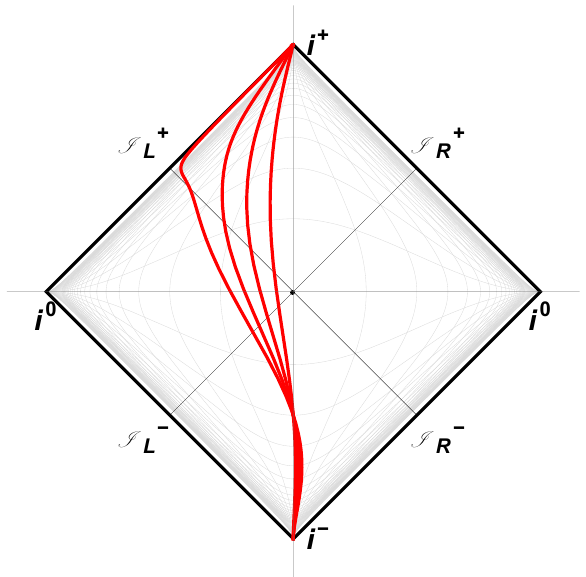
Figure 1 . The trajectory, eq. (1.6), plotted in a Penrose conformal diagram. Here (cid:20) = 1 and (cid:24) = 0 : 25, 0 : 50, 0 : 75 and 0 : 99 respectively. The horizon location v H = 0. Notice that the mirror never forms a strict horizon as long as (cid:24) < 1: all left-moving modes ultimately re(cid:13)ect and become